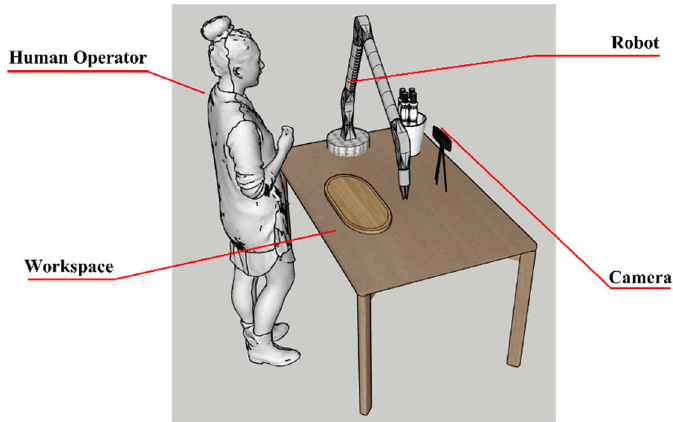
Figure 12. 3D Visualization.